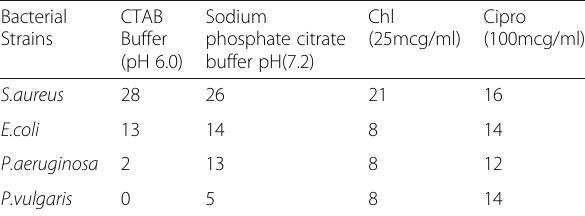
Table 2 Data of diameter of zone of inhibition of protein extracts from two different buffers after Dialysis Bacterial Strains